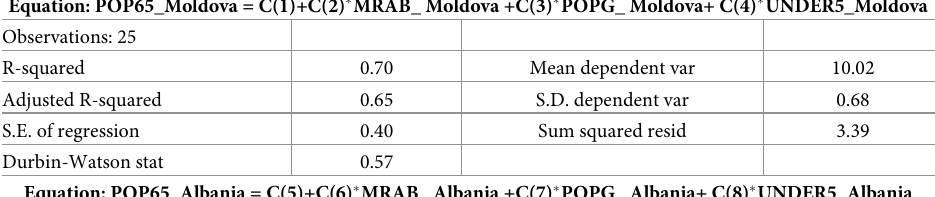
Table 3. System estimation by country equation.